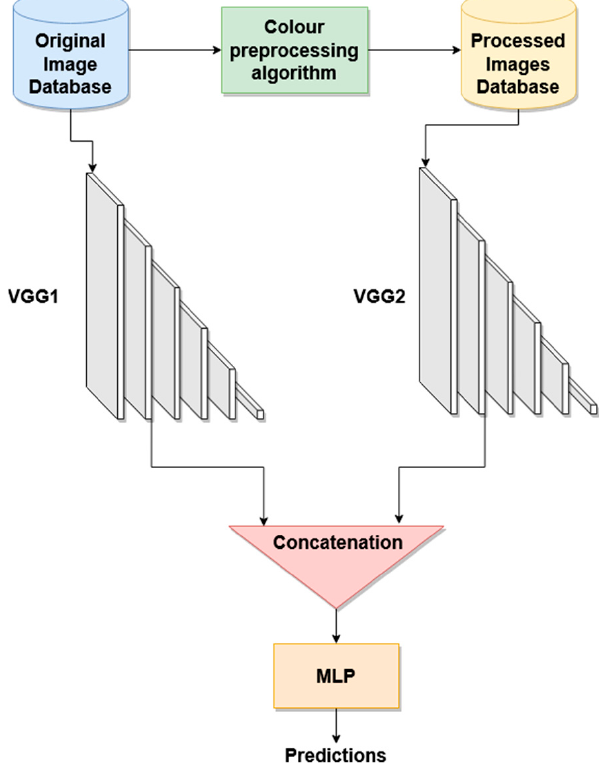
Figure 5. Dual classification. Original RGB and color-quantized images are used as inputs to the VGG16 CNNs, and concatenated to enter in a MLP classifier.